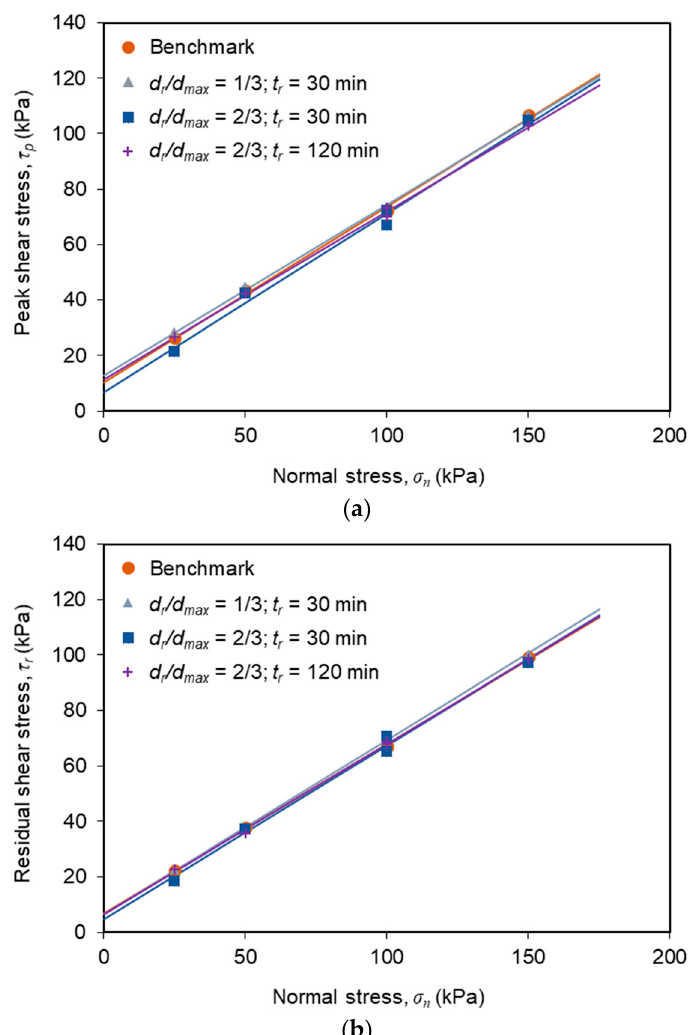
Figure 7. Interface shear strength envelopes from conventional (benchmark) and multistage tests: ( a ) Peak strength envelopes; ( b ) Residual strength envelopes. Table 5. Peak and residual interface shear strength parameters.